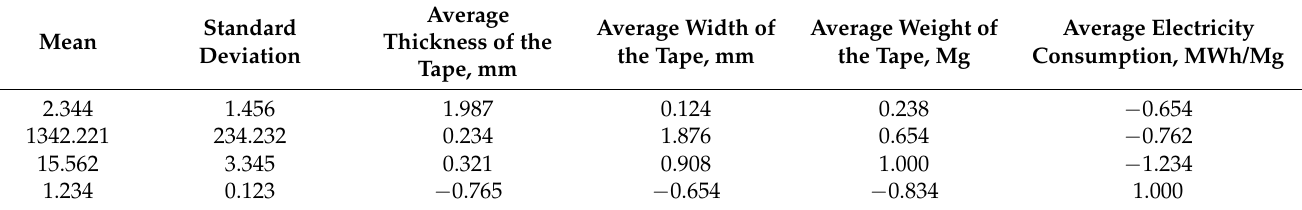
Table 2. Correlations of key process parameters and electricity consumption per ton of